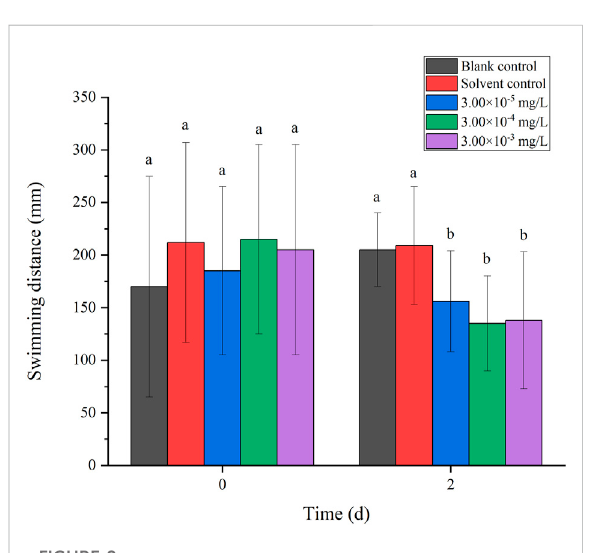
FIGURE 8 Effects of tebuconazole on the swimming distance of zebra fi sh larvae locomotion. Data are expressed as the mean ± SD and different alphabets denote signi fi cant differences between the exposure treatments for each day ( p < 0.05, one-way ANOVA). Signi fi cant differences were found at 0 d (F = 4.93, dfb = 4, dfw = 10) and 2d (F = 5.12,